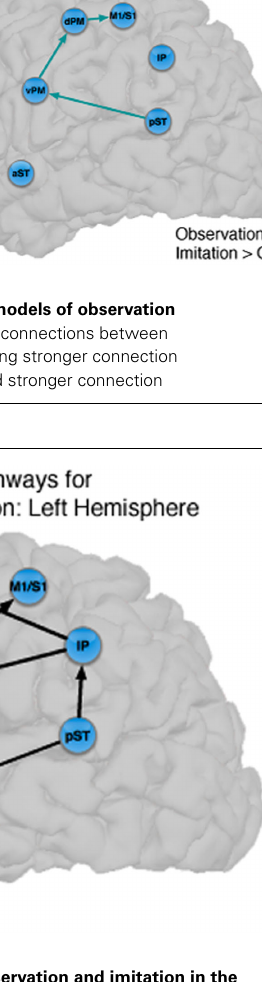
FIGURE 4 | Common pathways for observation and imitation in the LH. Observation and Imitation models in the LH with connections between pST, aST, IP, vPM, dPM, and M1S1. Black arrows show the connections that did not differ statistically across the Observation and Imitation models. For a key to abbreviations, please see the legend to Figure 2 and Table 1